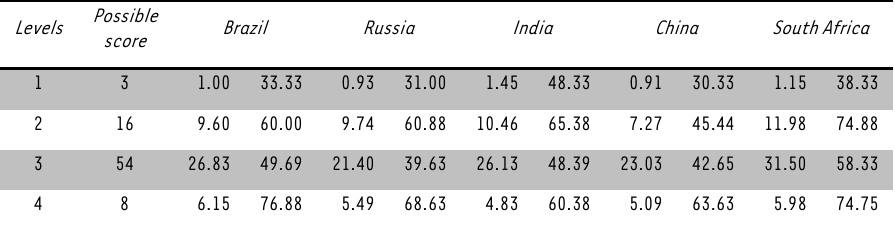
TABLE 5: Element 3 - Professional practices Possible Levels score